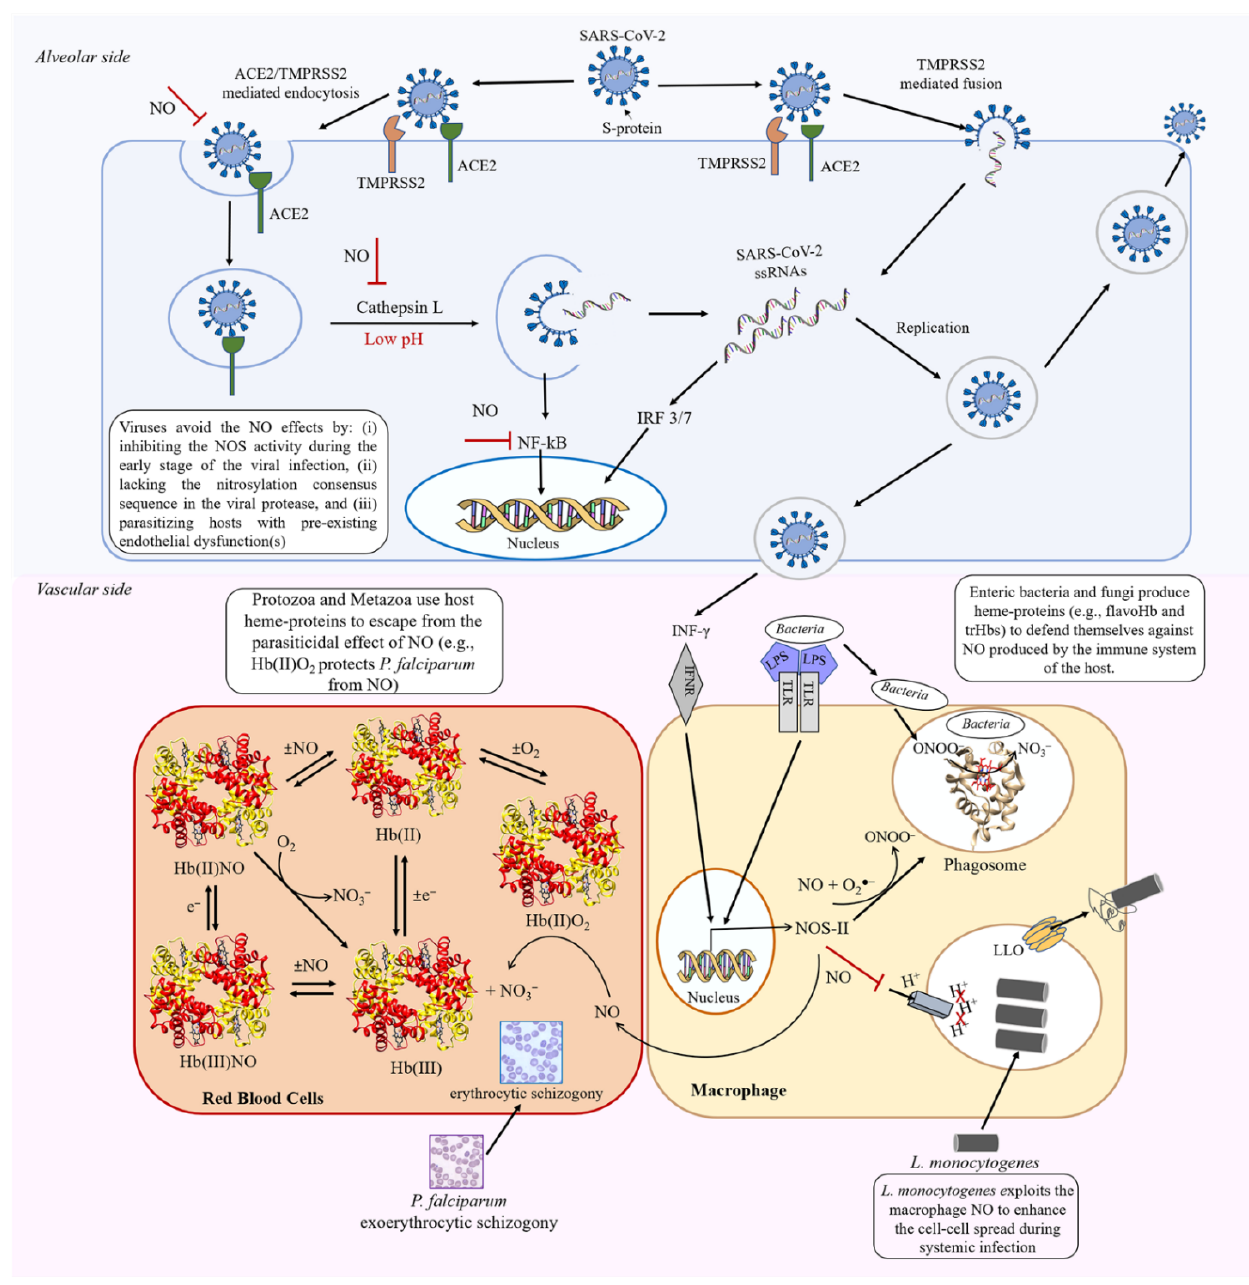
Figure 6. Overview of pathogen strategies to escape from NO-based host defense.